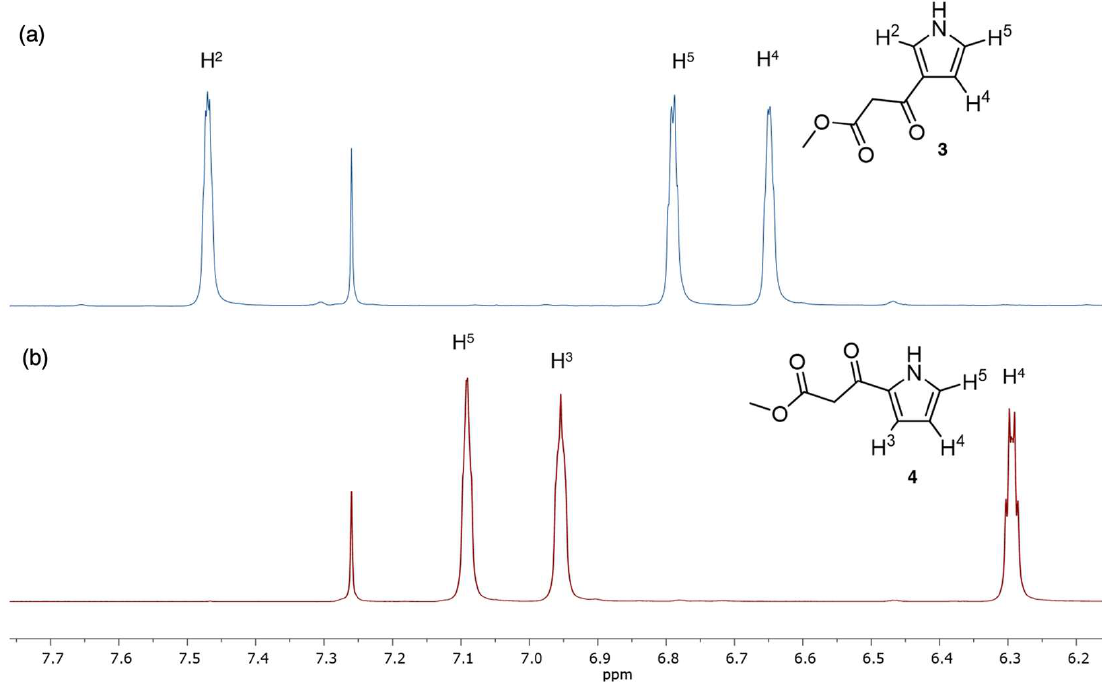
Figure 1. 1 H-NMR spectral region of two isomers (in CDCl 3 at room temperature): ( a ) the 3- substituted pyrrole ( 3 ) and ( b ) the 2-substituted pyrrole ( 4 ).